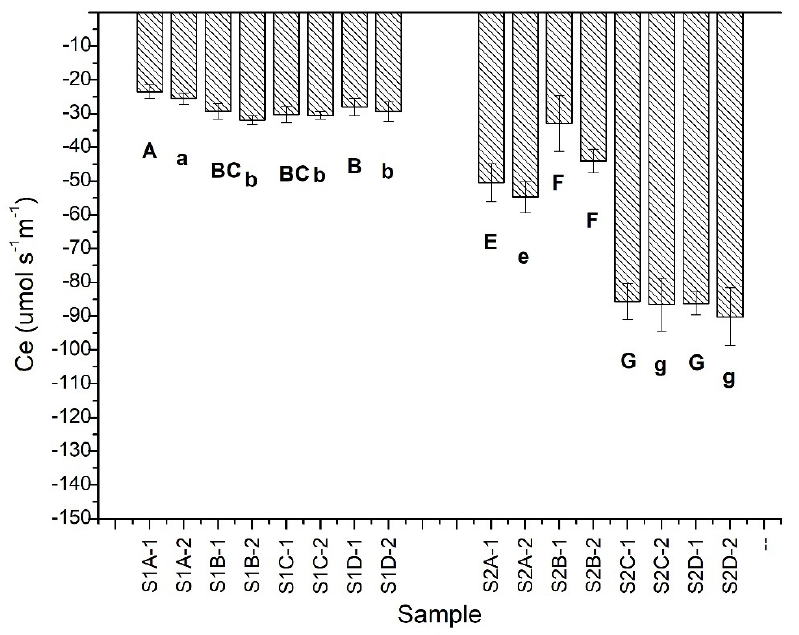
Figure 4. Soil respiration Ce in the studied soils. S1: soil from the limestone open-cast mining remediated with embankment; S2: soil from the lignite open-cast mining remediated with sewage sludge; subsequent letters A–D mean different remediated areas located at the same mine; subsequent numbers mean different sampling periods; 1: spring 2021, 2: spring 2022. Mean values ± SD, n = 3. Different letters with bars indicate significant differences between tested treatments ( p < 0.05) according to Tukey’s test. Small and large letters indicate separate analyses for both sampling soils.